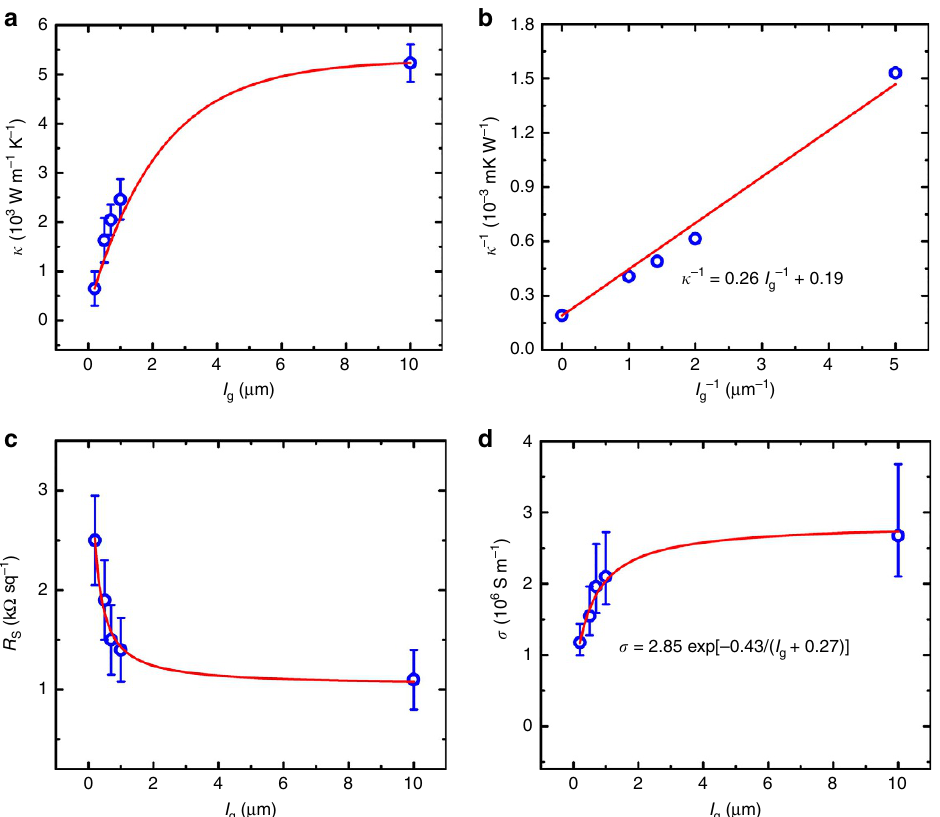
Figure 4 | Thermal and electrical transport of the graphene films with different grain sizes. ( a ) Thermal conductivity as a function of grain size with a fit (red curve). The error bars (standard error of the mean, s.e.m.) represent the thermal conductivity variation measured for the same sample. ( b ) The inverse of thermal conductivity as a function of the inverse of grain size with a fit (red curve), showing a linear relationship. ( c ) Sheet resistance as a function of grain size with a fit (red curve). ( d ) Electrical conductivity as a function of grain size with a fit (red curve), showing an exponential relationship. The error bars (s.e.m.) in c and d represent the electrical conductivity variation measured for the same sample and the samples prepared with the same